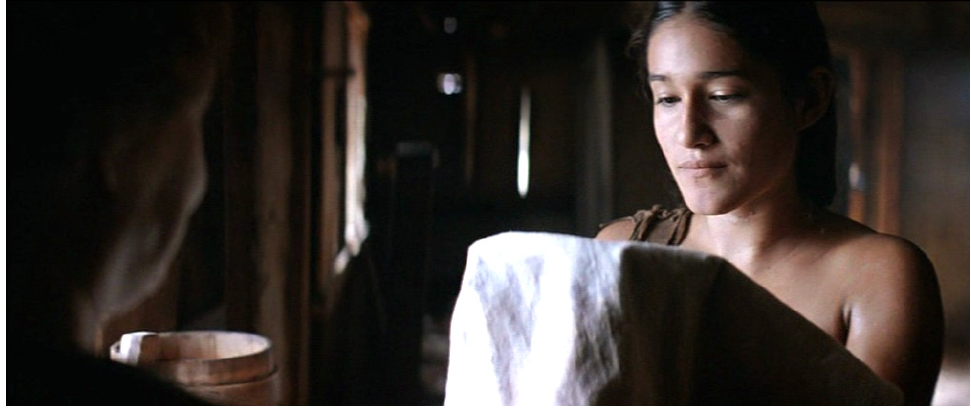
Figure 15: Pocahontas helps Smith with his ablutions (cf. her baptism in Figure 13.)